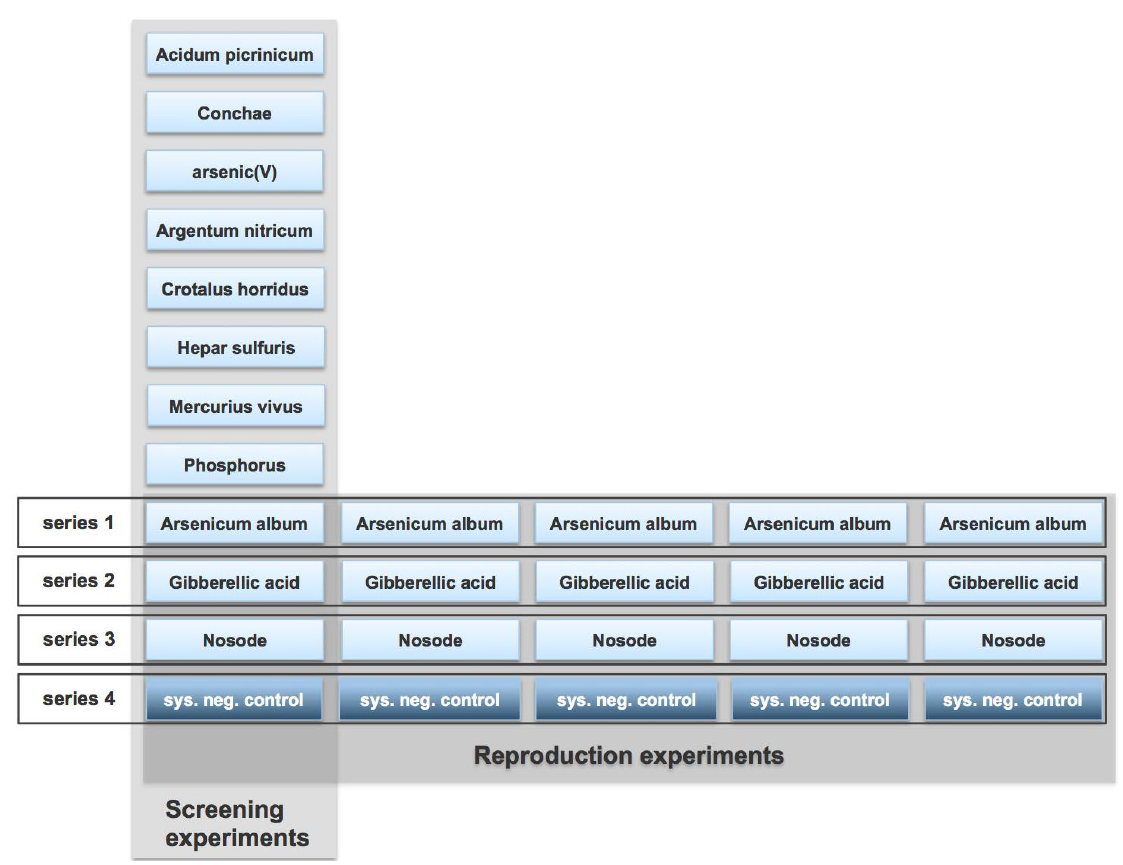
FIGURE 1. Overview of all analyzed experiments. One box corresponds to one single experiment. The data evaluation of the four main experimental series (1–4) comprised five independent experiments each. (sys. neg. control = systematic negative control